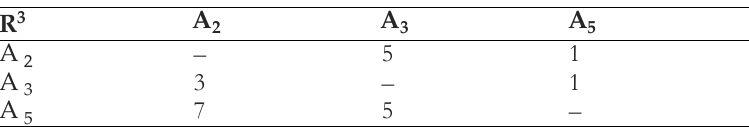
Table 10. Comparing based on the Table